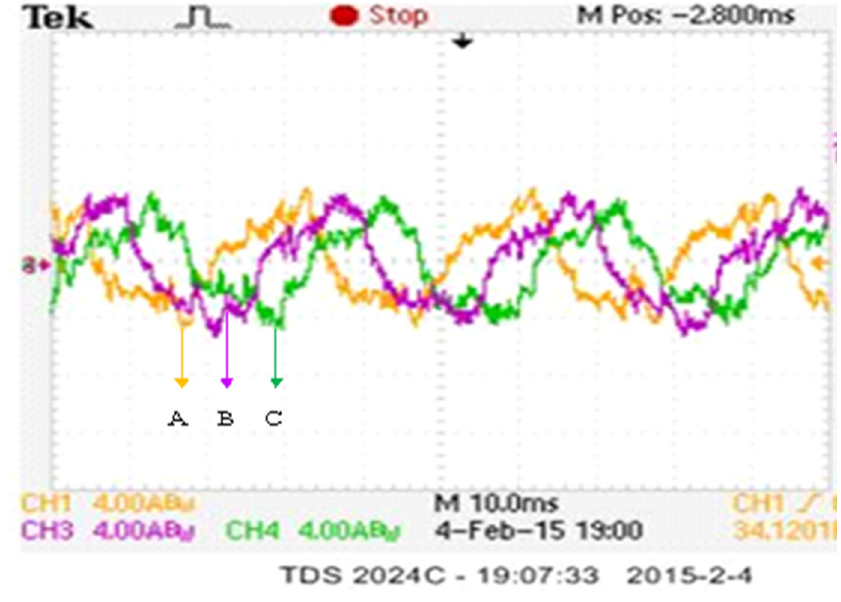
Figure 27. The measured current waveform of 1 kW